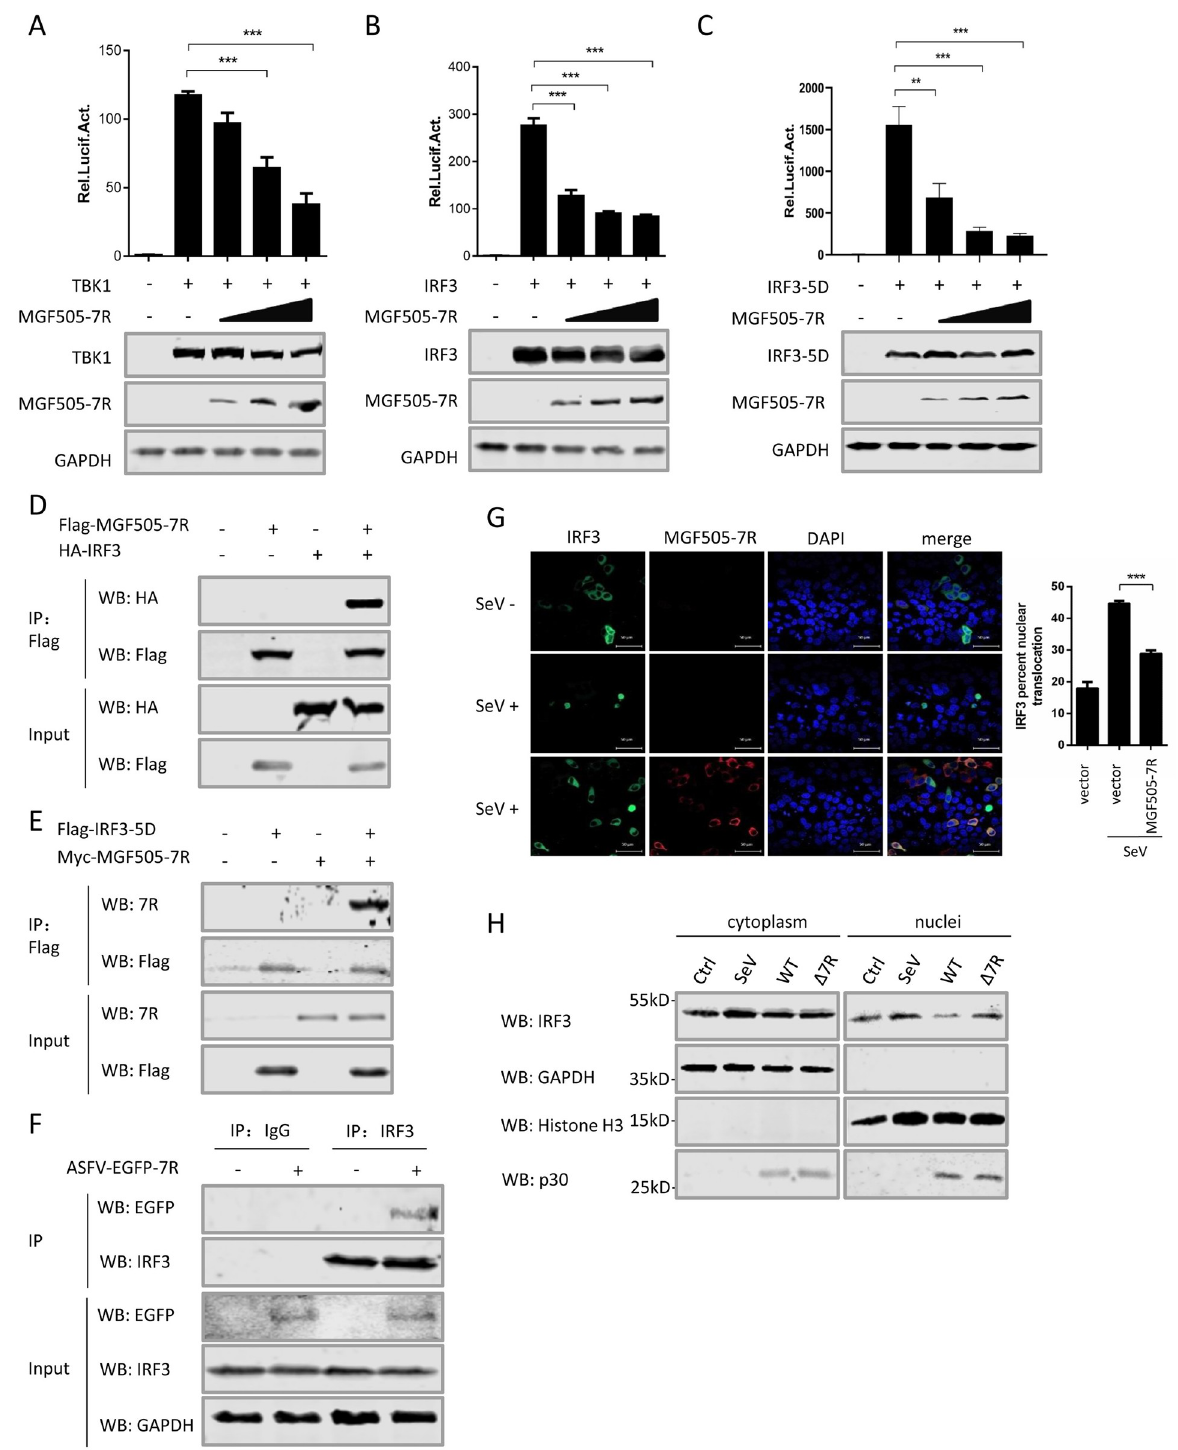
Fig 8. pMGF505-7R targets IRF3 to inhibit IFN- β production. (A-C) HEK293T cells were transfected with IFN- β reporter, different amounts (0, 100, 200 or 400 ng) of a plasmid encoding pMGF505-7R, together with a plasmid encoding TBK1 (A) , IRF3 (B) or IRF3-5D (C) . 24 hpt, the cells were lysed and the activities of the IFN- β reporter were assessed by the luciferase assay. The expressions of TBK1, IRF3 and pMGF505-7R were detected by Western blotting. GAPDH served as a loading control. (D-E) HEK293T cells were transfected with a plasmid encoding pMGF505-7R along with a plasmid encoding HA-IRF3 or HA-IRF3-5D as indicated. 36 hpt, the cells were lysed and whole cell lysates were immunoprecipitated